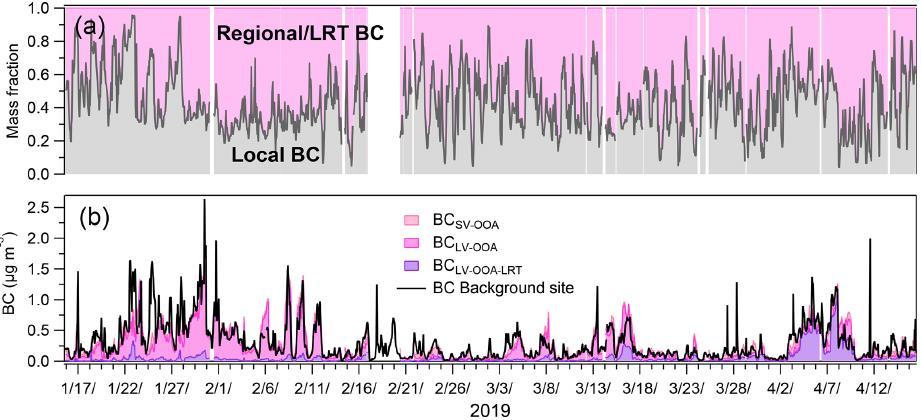
Figure 2. Regional or long-range-transported vs. local BC in the residential area. The distribution of BC to local and regional–LRT BC at the residential site (a) , and the time series of BC LV-OOA , BC LV-OOA-LRT , and BC SV-OOA at the residential site (stacked) compared with total BC at the background site (b) .